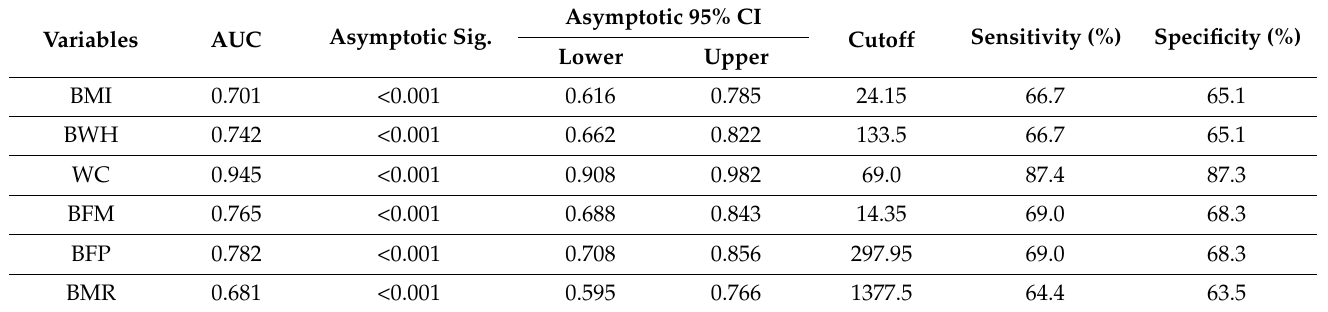
Table 6. Area under the curve (AUC) and cutoff values of anthropometric indices to estimate insulin resistance between obese children and